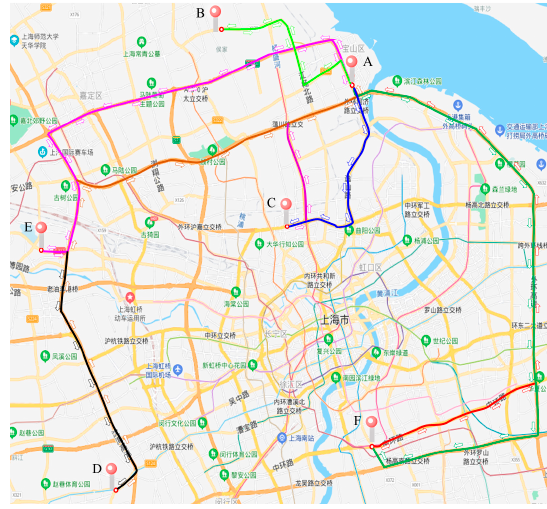
Figure 2. Daily driving route in Shanghai. Table 2. Detailed information for the five vehicles.